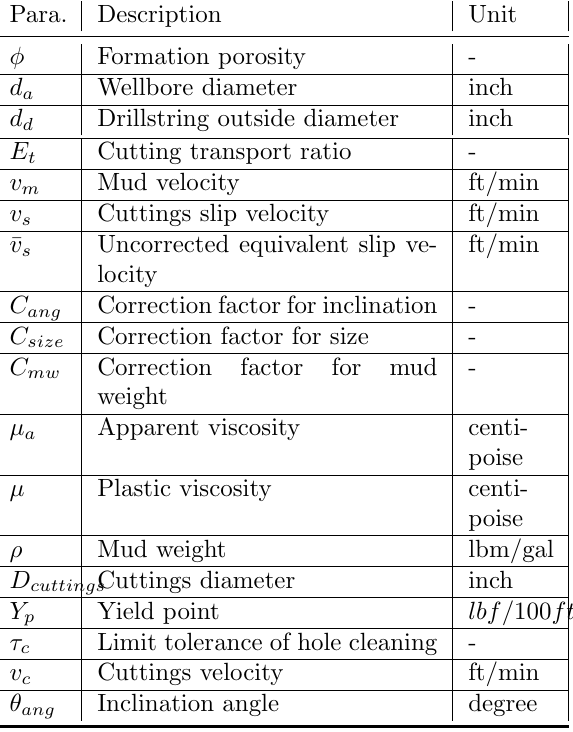
Table 2: Drilling parameters used in Section